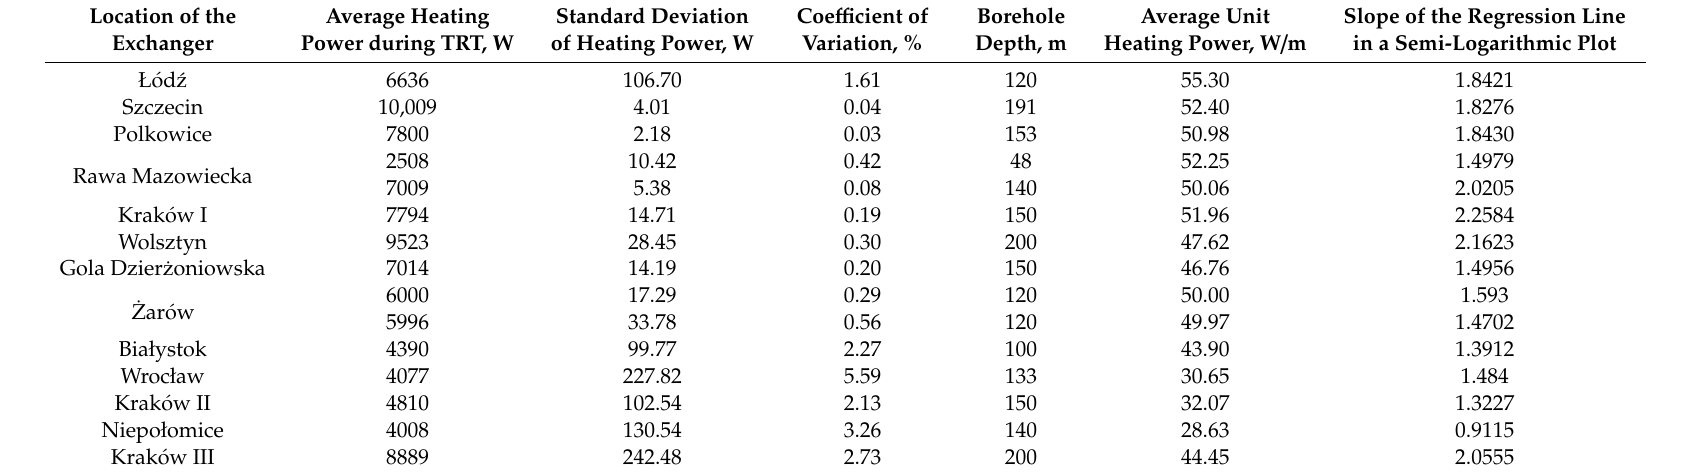
Table 7. Parameters of the tested exchangers, with the interval of every 60 min.